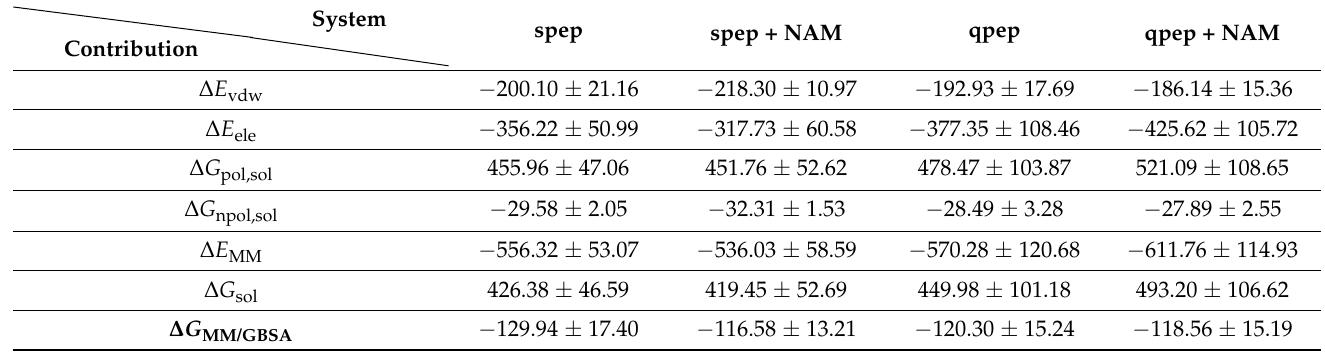
Table 1. The components of the PTH binding free energy (kcal/mol) of each system. System spep spep + NAM qpep qpep + NAM Contribution ∆ E